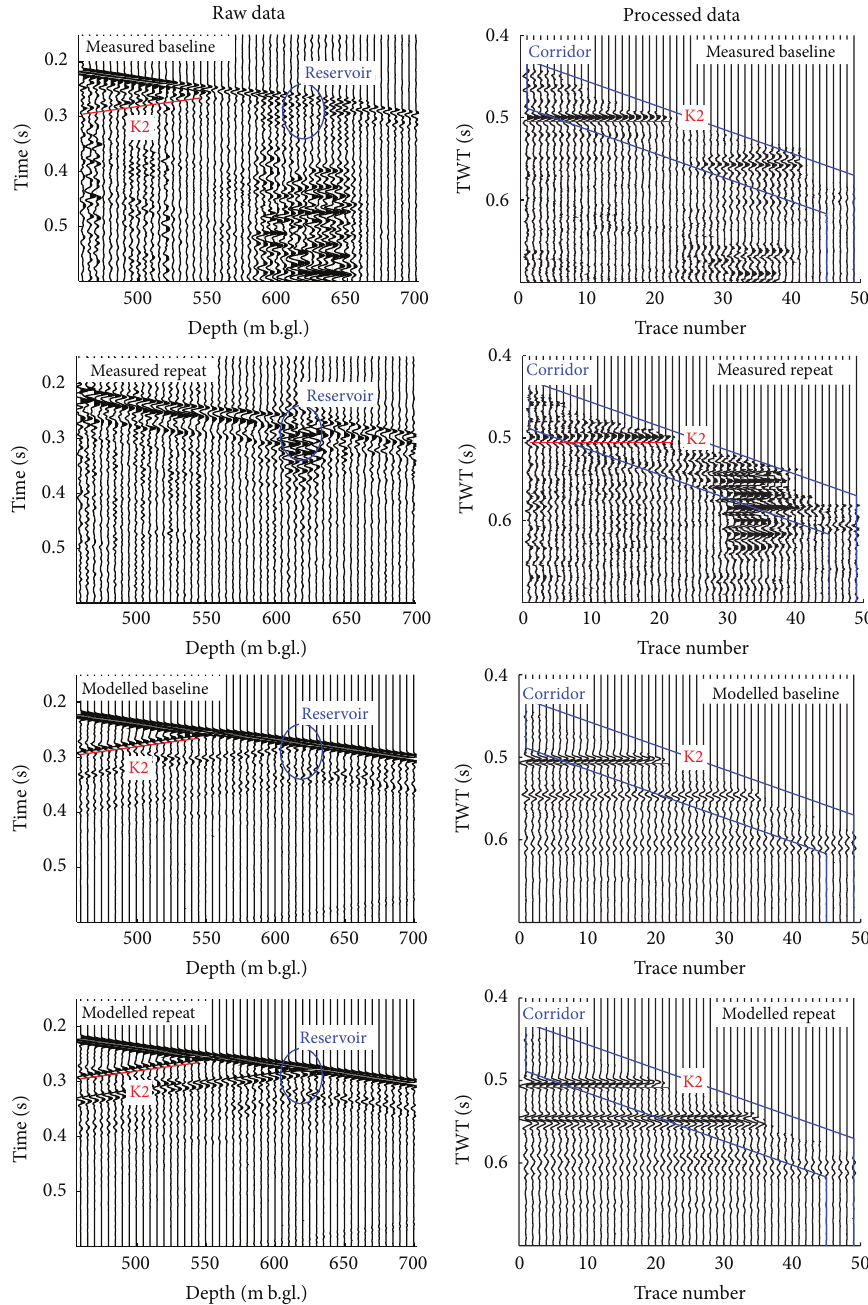
Figure 4: Zero-offset VSP vertical component, raw data (left column), and processed data after removal of downgoing waves, horizontal alignment, and enhancement of upgoing waves (right column). The measured baseline, measured repeat, modelled baseline, and modelled repeat data are shown from top to bottom. Reflections from an anhydrite layer (Figure 3, ∼ 550 m below ground level), labelled K2, are marked by red lines and the depth of the reservoir is indicated by the blue circle. The blue polygons denote the corridor mute window.